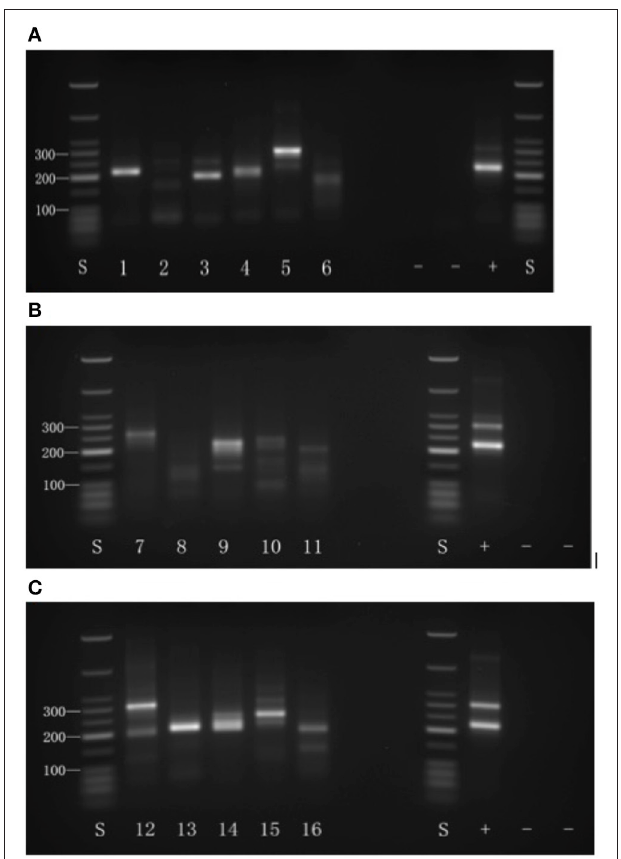
FIGURE 1 | Results of 3 ′ -RACE shown by 2% agarose gel electrophoresis. S, sizer; − : negative control; + : positive control. (A) Selected genes #1–6. (B) Selected genes #7–11. (C) Selected genes